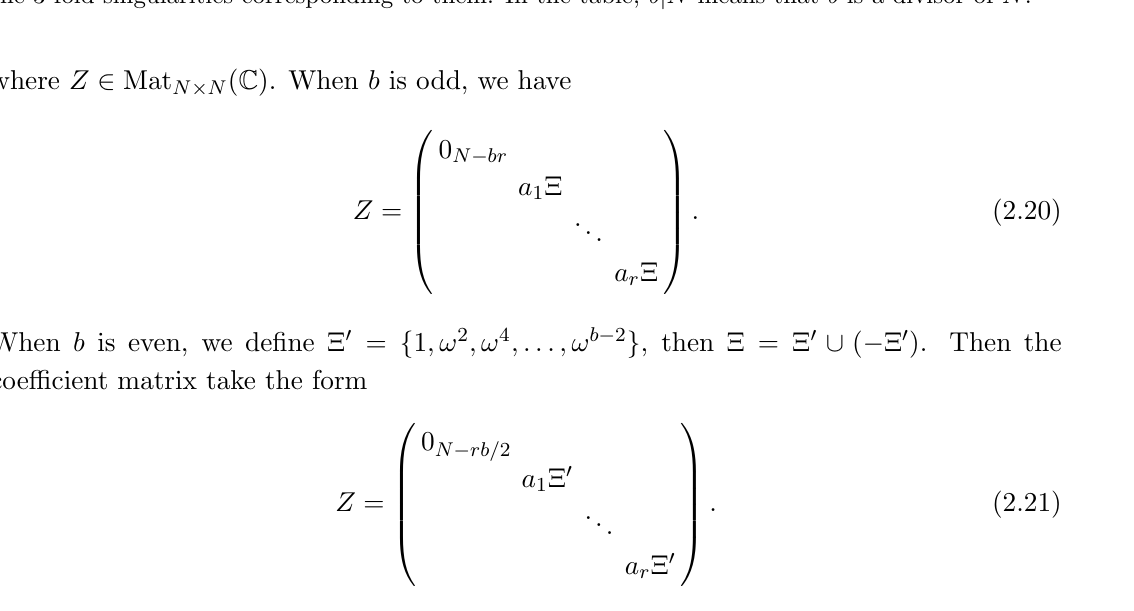
Table 1 . Classi(cid:12)cation of irregular singularities with regular semisimple coe(cid:14)cient matrices and the 3-fold singularities corresponding to them. In the table, b j N means that b is a divisor of N